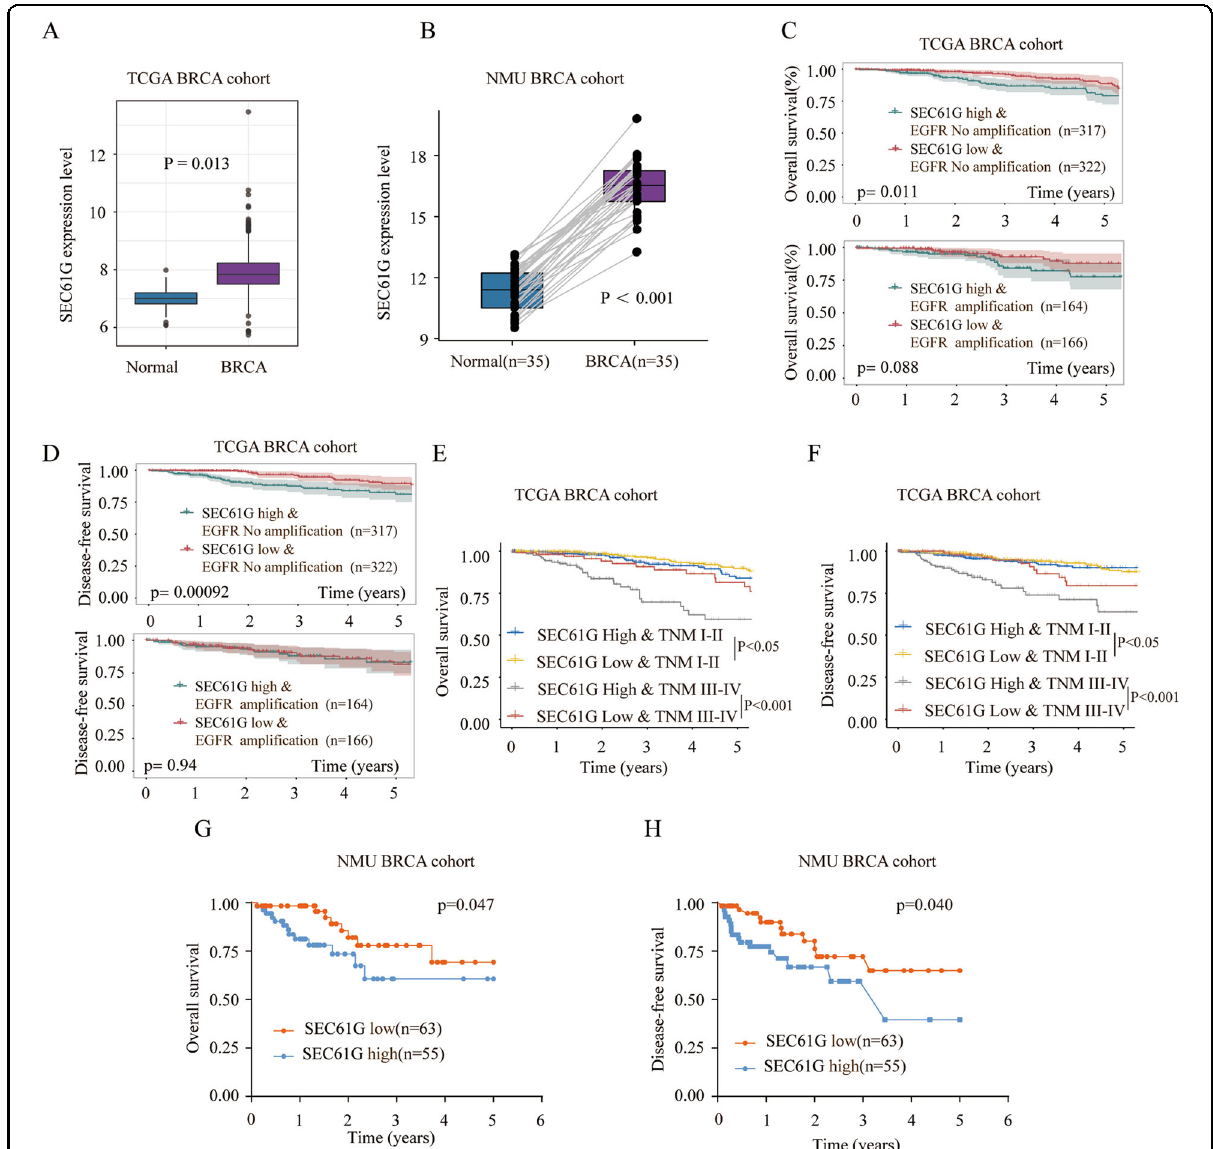
Fig. 1 SEC61G is highly expressed in breast cancer and predicts poor prognosis of breast cancer patients in TCGA BRCA cohort and the NMU BRCA cohort. A The expression level of SEC61G in breast cancer tissues or normal control tissues in TCGA BRCA cohort was analyzed. P = 0.013. B The relative expression of SEC61G in breast cancer tissues or normal control tissues in the NMU BRCA cohort was analyzed by qRT-PCR ( n = 35, P < 0.001). ( C , D ) Kaplan – Meier analysis of overall survival (OS) and disease-free survival (DFS) in breast cancer patients with high or low SEC61G expression in TCGA BRCA cohort, combined with EGFR ampli fi cation or not. E , F Kaplan – Meier analysis of the OS and DFS of breast cancer patients with high or low SEC61G expression at different TNM stages in TCGA BRCA cohort. G , H Kaplan – Meier analysis of the OS and DFS of breast cancer patients with high or low SEC61G expression in the NMU BRCA